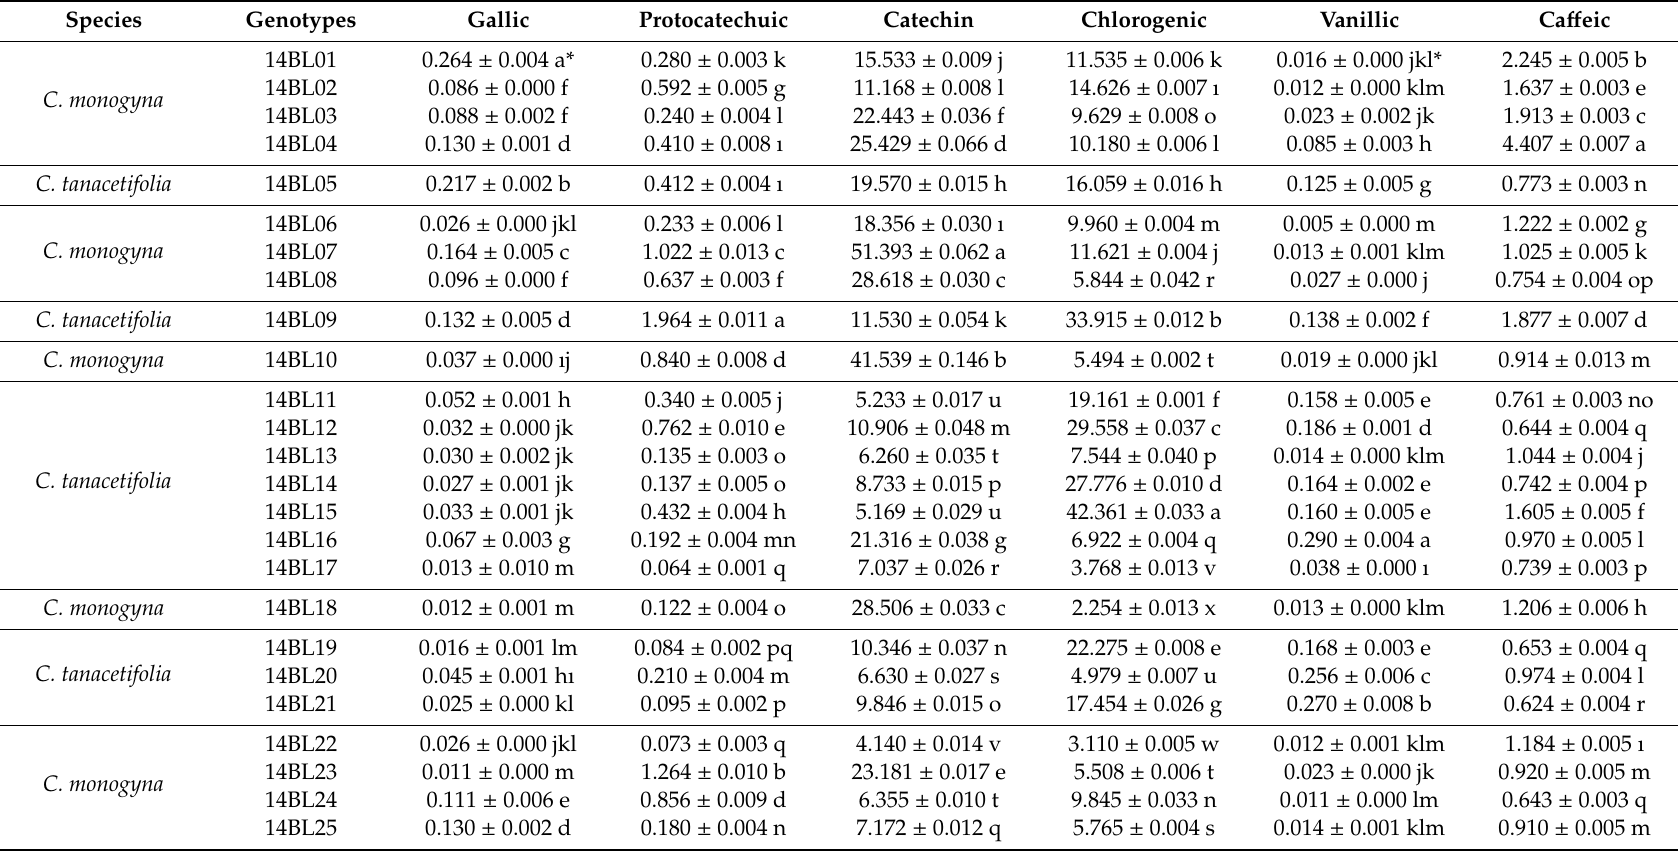
Table 2. Phenolic compound contents of hawthorn genotypes (mg 100 g − 1